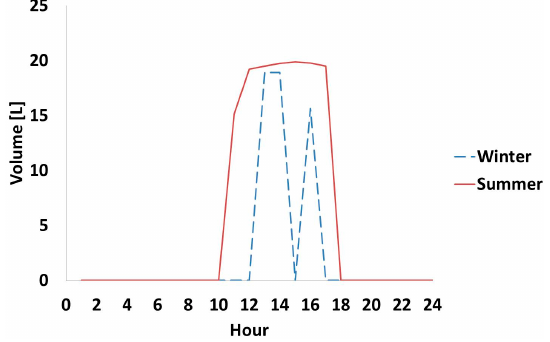
Figure 16. MD production in a typical day per season.